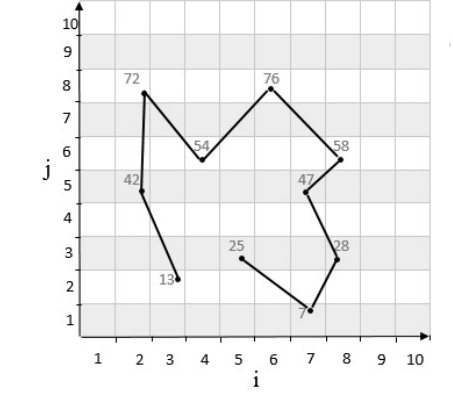
Figure 1. Movement pattern of u 1 in grid cell with m × m